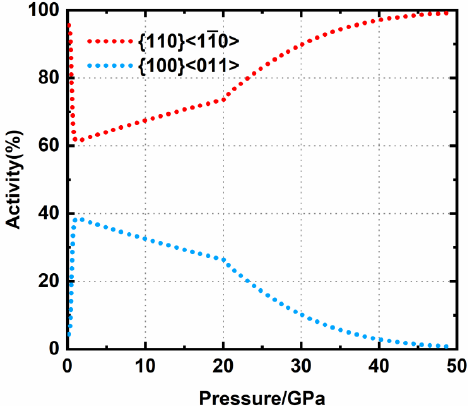
(cid:68) (cid:69) 110 and { 100 }(cid:104) 011 (cid:105) slip systems are